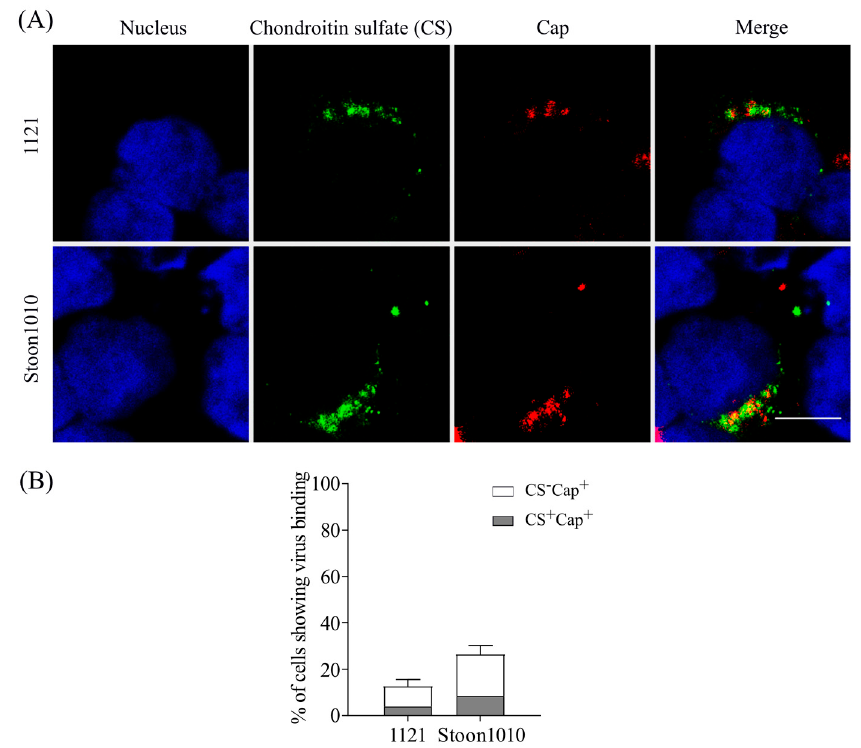
Figure 5. Colocalization of chondroitin sulfate (CS) and PCV2 Cap. T-lymphoblasts were incubated with PCV2 particles at 4 ◦ C for 1 h, after which the virus was removed and cells were fixed. The expression of CS was stained in green, while the bound PCV2 particles were stained in red. Cell nuclei were stained in blue. ( A ) Representative pictures of PCV2 binding to CS-expressed T-lymphoblasts. Scale bar = 8 µ m. ( B ) The percentages of T-lymphoblasts showing PCV2 binding and CS expression were calculated. The proportion of cells with bound PCV2 particles and CS expression (CS + Cap + ) was presented in grey, and that with PCV2 binding but not CS expression (CS − Cap + ) in white.